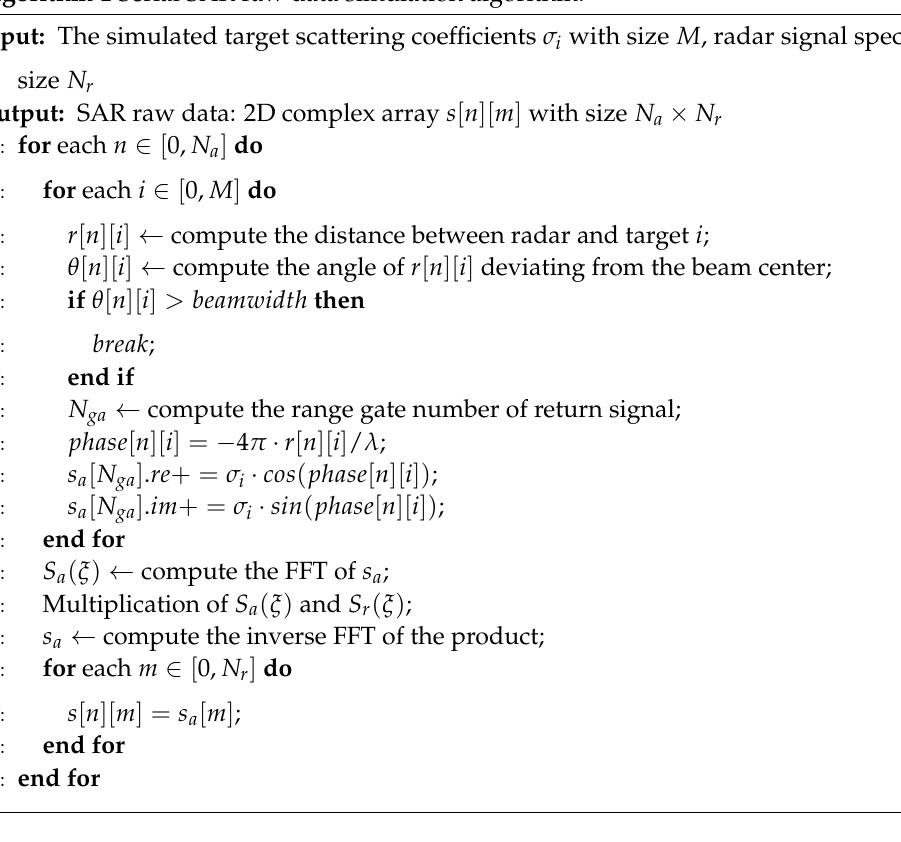
Algorithm 1 Serial SAR raw data simulation